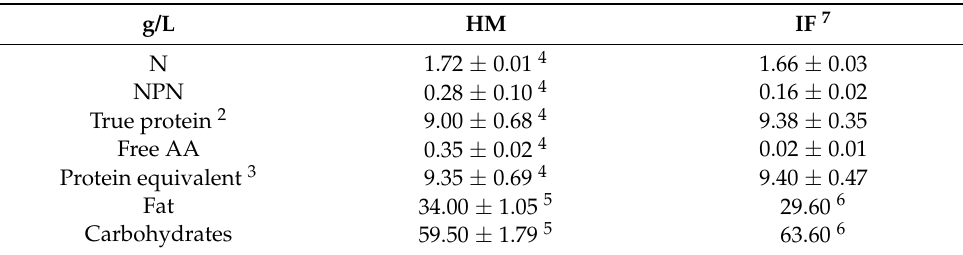
Table 1. Nutritional composition of the test products 1